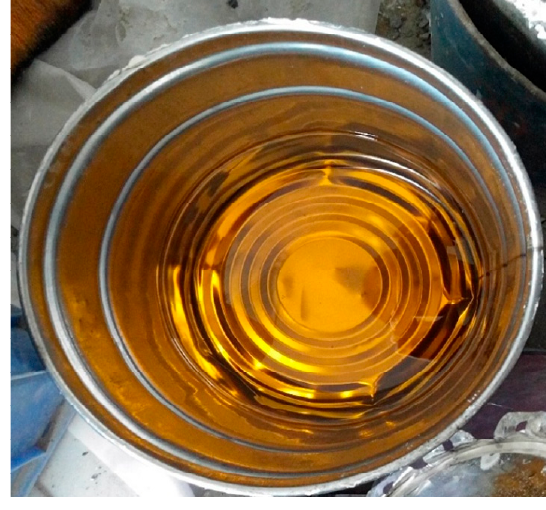
Figure 1. Vinyl ester resin.